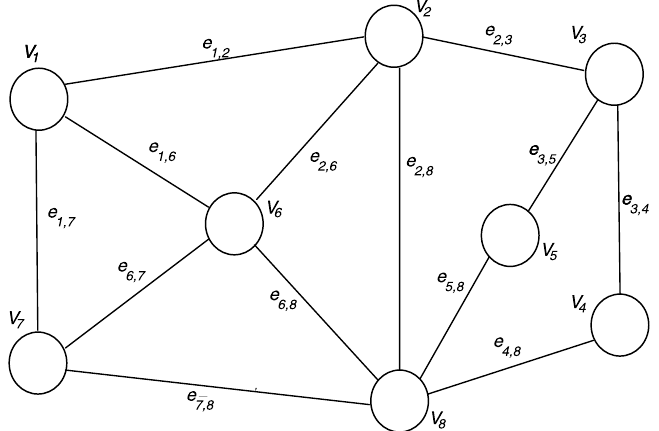
Figure 3. Example of Undirected Graphs.